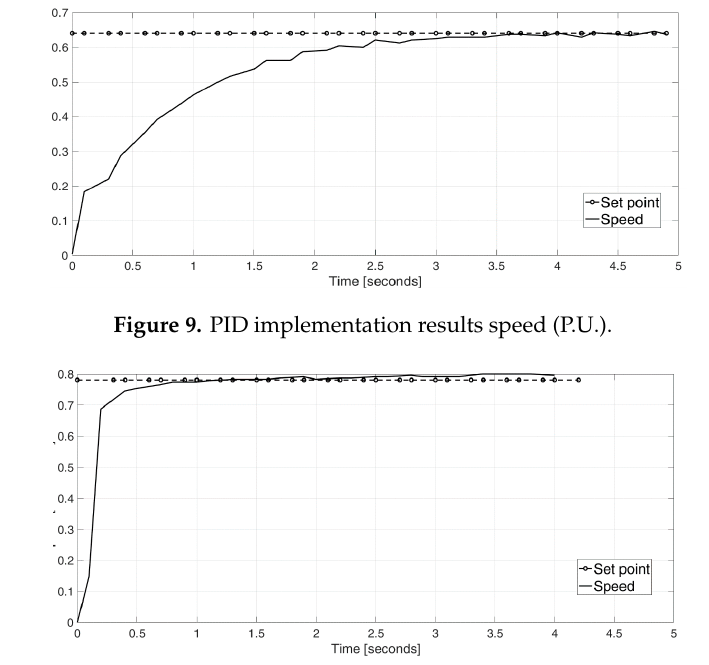
Figure 10. Experimental speed (P.U.) results when the SMC-organic network (SMC-ON) speed controller is implemented.